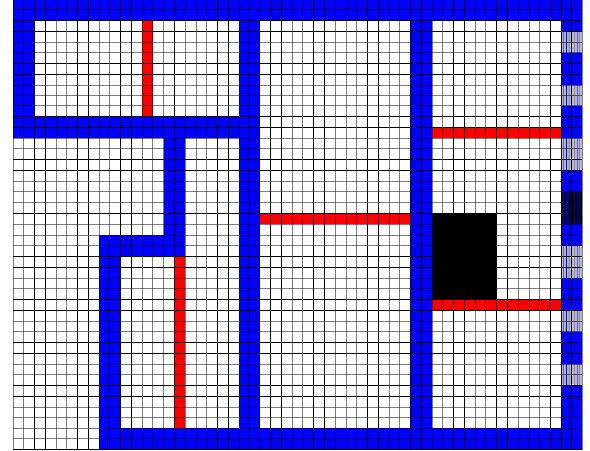
Figure 12. Final labeled plan with walls, facade, and stair information.